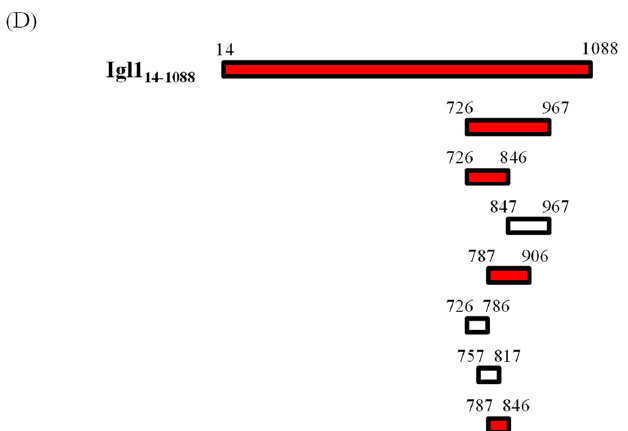
Figure 1. Hemolytic activity of recombinant Igl1 fragment proteins based on Igl1 726-967 . ( A ) Purities and amounts of recombinant proteins were confirmed by SDS-PAGE, with 1 μ g of each protein run on the gels. ( B ) HoRBCs were incubated in a 96-well plate with Igl1 fragment proteins for the indicated periods. Representative images of 5 independent studies are shown. ( C ) Concentrations of hemoglobin (Hb) released in the supernatant of samples incubated for 6 h. Data are the mean + SD from 5 independent experiments. Hemolytic activities of Igl1 fragments shown in bars with asterisks were significantly higher than those of phosphate-buffered saline with 0.05% Tween 20 (PBST) (* p < 0.05, ** p < 0.01 by ANOVA with a Dunn test). ( D ) Summary of data for fragment proteins with hemolytic activities. Recombinant Igl1 fragments with hemolytic activity are shown in red bars. Open bars indicate fragment proteins without this activity.